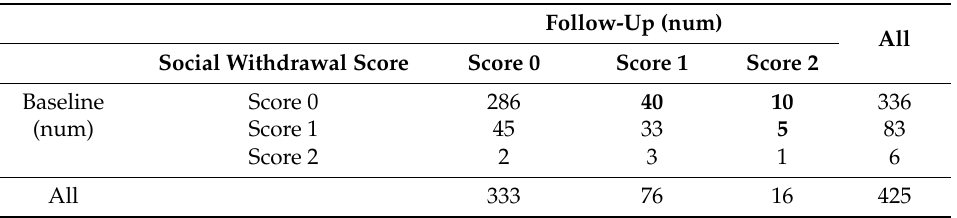
Table 4. The results of social withdrawal score.